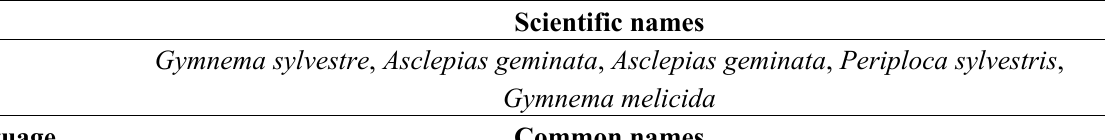
Table 1. Scientific and common names of Gymnema sylvestre